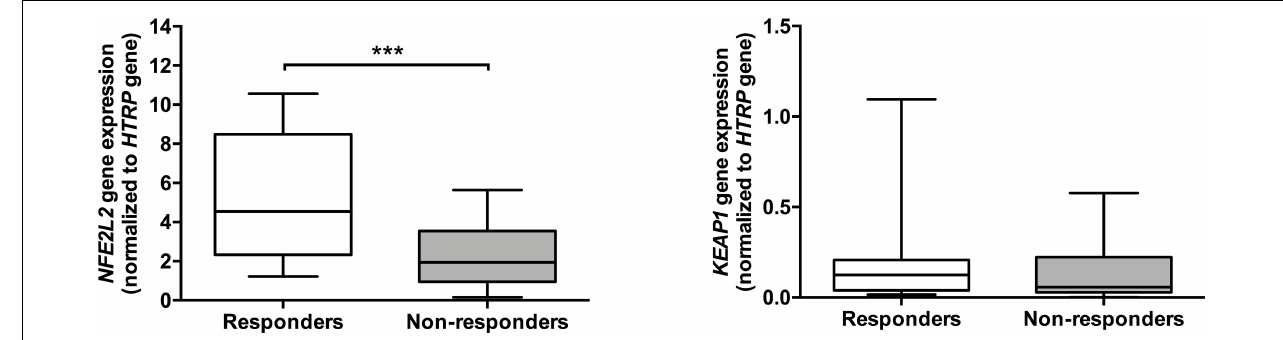
FIGURE 2 | Expression of NFE2L2 and KEAP1 genes in patients with myelodysplastic syndrome according to their response to ESA treatment. The RNA expression for NFE2L2 and KEAP1 genes were normalized to the HPRT gene (endogenous control). *** p ≤ 0.001.